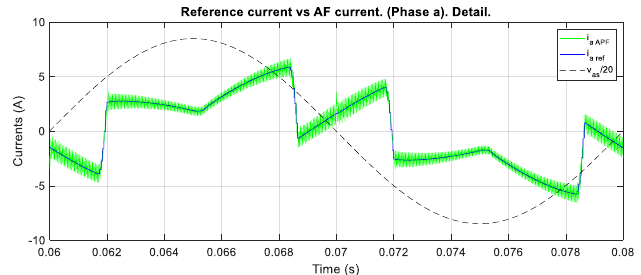
Figure 10. Current tracking performance for phase a .